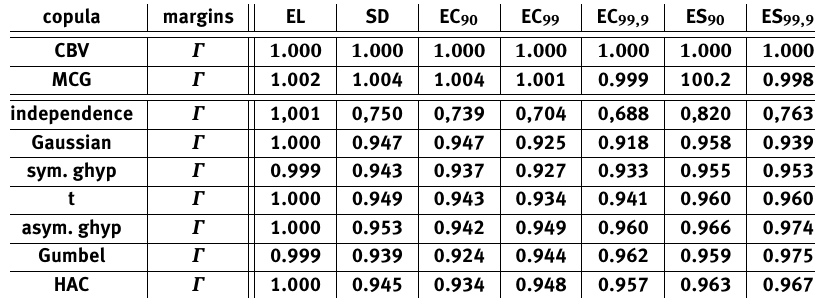
Table 7. Risk figures for different